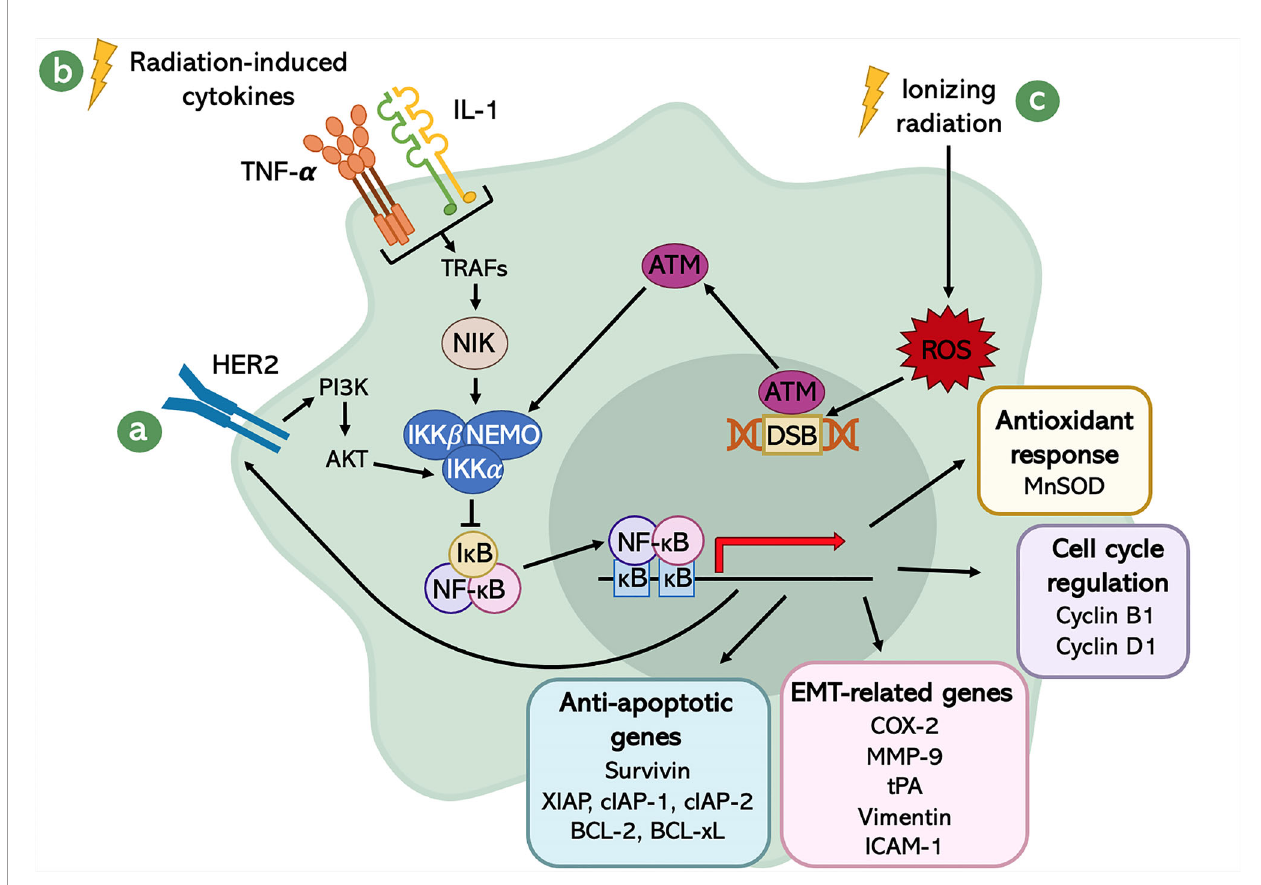
FIGURE 3 | Schematic representation of the radiation-induced NF- k B signaling network. The activation of NF- k B is mediated by different stimuli: (A) the EGFR signaling pathway, especially through the activity of HER2; (B) the radiation-induced cytokines; and (C) DSBs generated by IR-induced ROS. The transcriptional program of NF- k B leads to several downstream events, which result in enhanced aggressiveness, increased survival and better fi tness of cancer